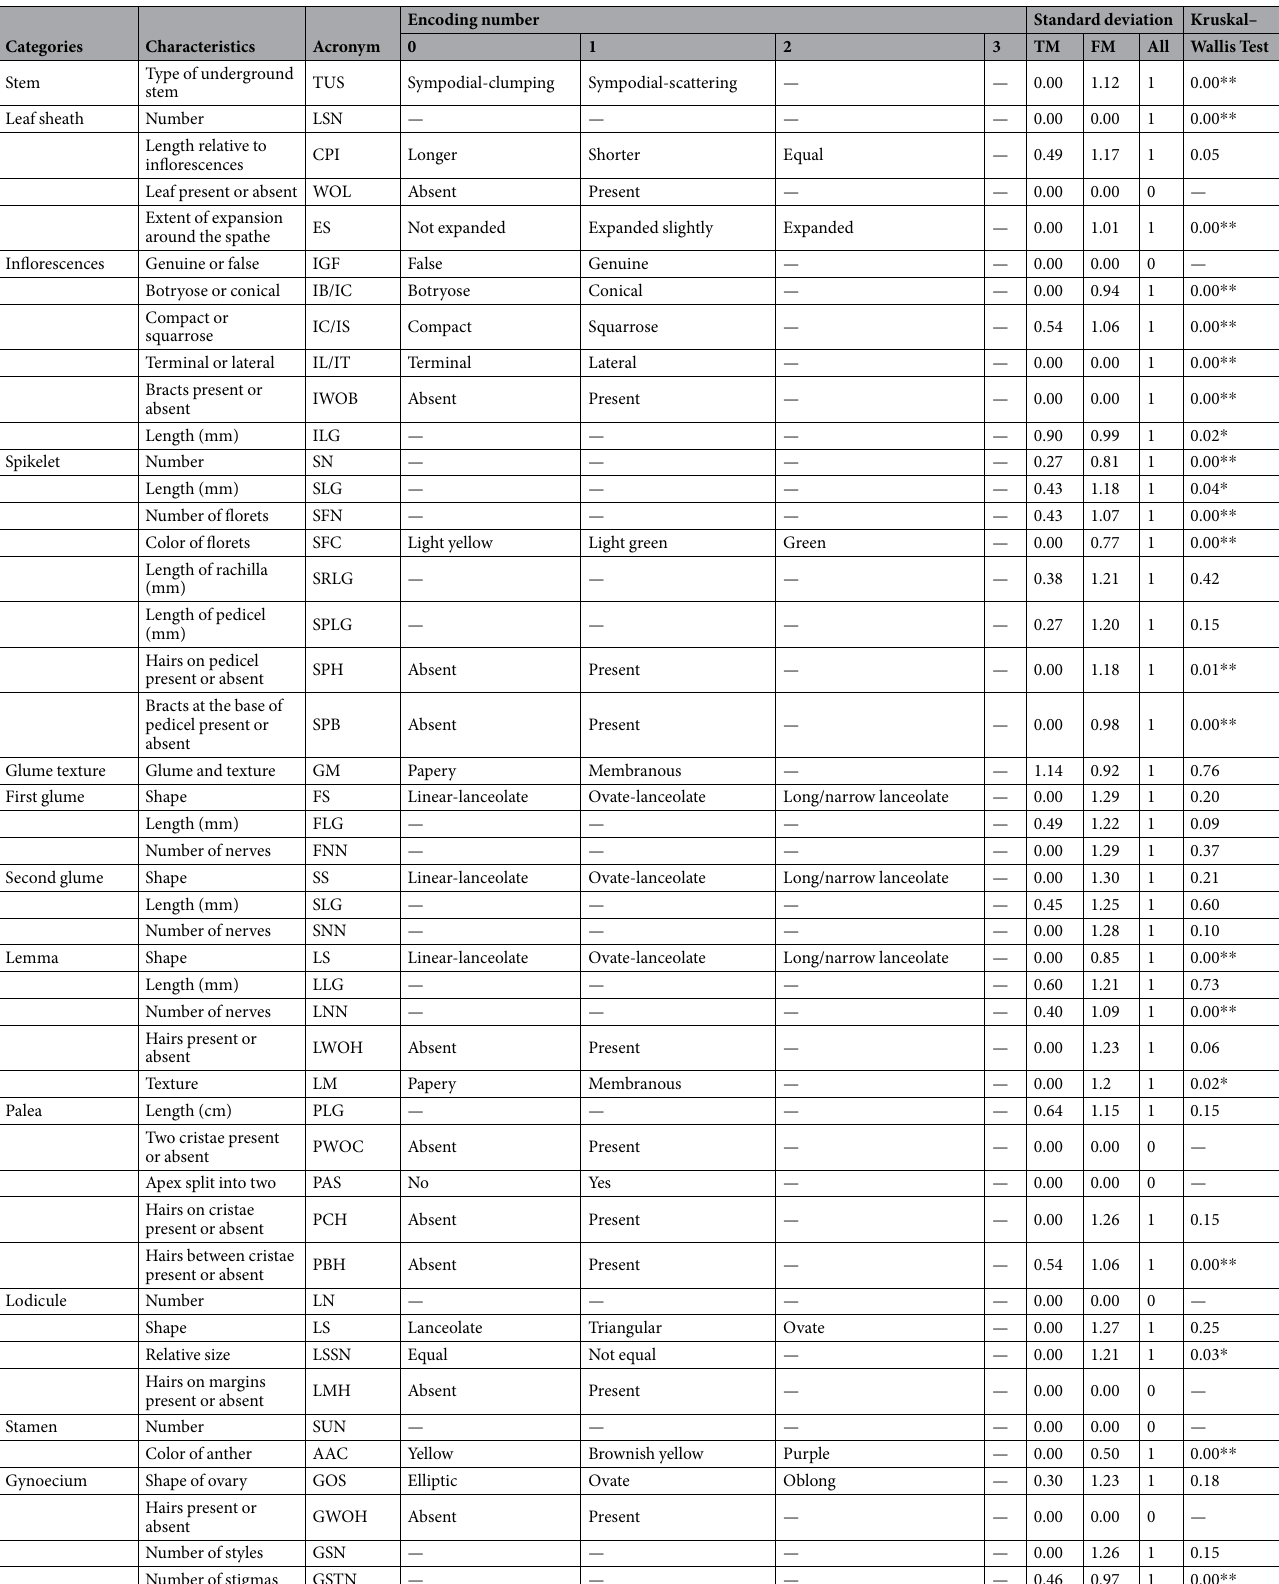
Table 2. Coding of qualitative characteristics into binary or ordered multistate characteristics. The significance of differences and standard deviations between Fargesia and Thamnocalamus were calculated with the Kruskal– Wallis test. ** P < 0.01, * P < 0.05. TM, the mean standard deviation (SD) of Thamnocalamus species; FM, the mean SD of Fargesia species; All, the SD of Fargesia and Thamnocalamus